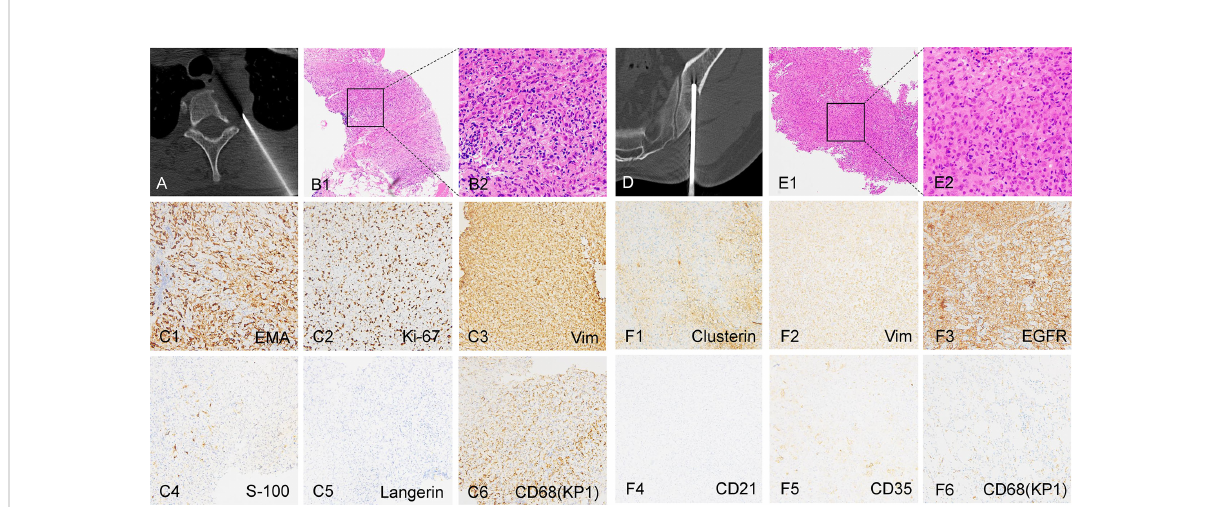
FIGURE 2 Biopsy and staining images of the tumors. (A, B) CT-guided core needle biopsy and the H&E staining images of the thoracic lesion. (C1-C6) Immunohistochemical staining of the thoracic lesion. (D, E) CT-guided core needle biopsy and the H&E staining images of the left ilium lesion. (F1-F6) Immunohistochemical staining of the left ilium lesion. B1, E1: 100×; B2, E2: 400×; (C, F) :